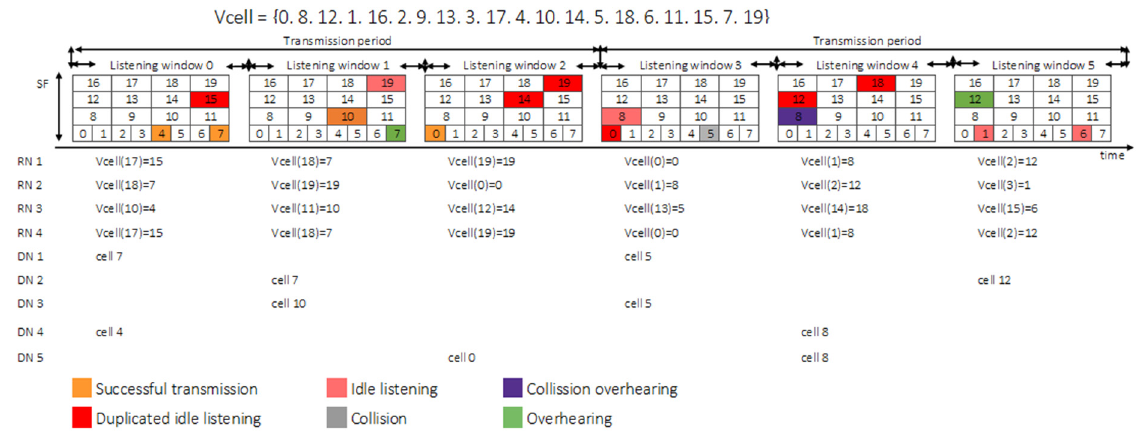
Figure 11. Summary of possible node activity during two transmission periods.